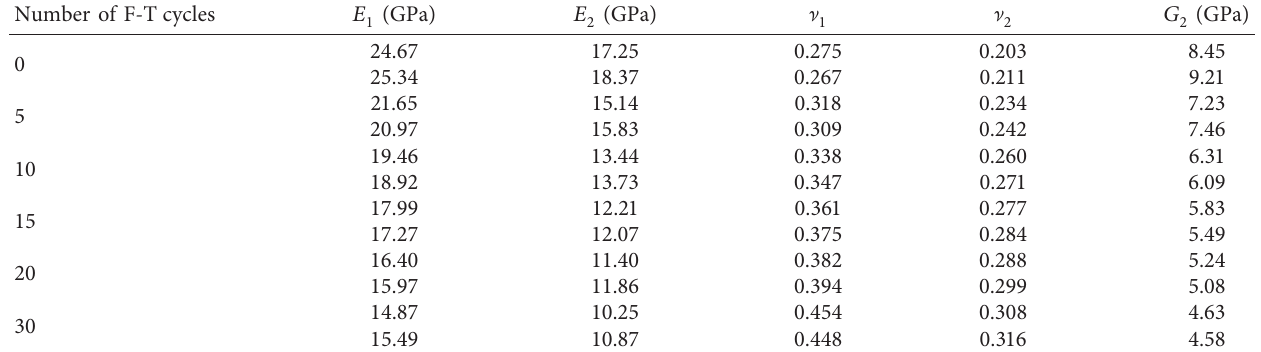
Table 2: Elastic constants of surrounding rock, a ′ Number of F-T